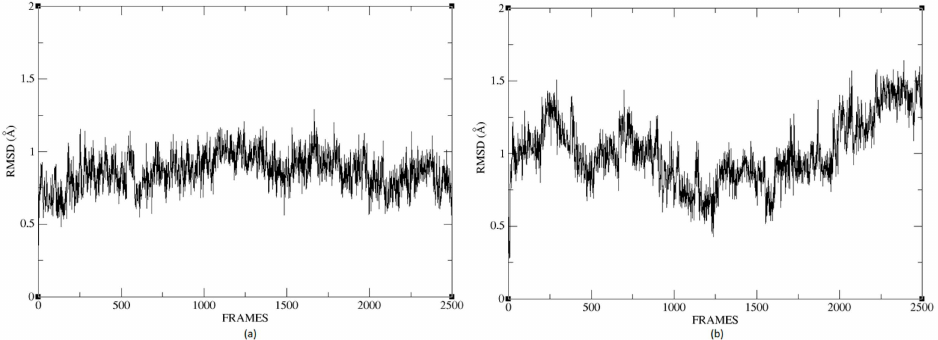
Figure 27. RMSD of the compounds during simulation of MD trajectories: ( a ) Ligand 1 and ( b ) Ligand